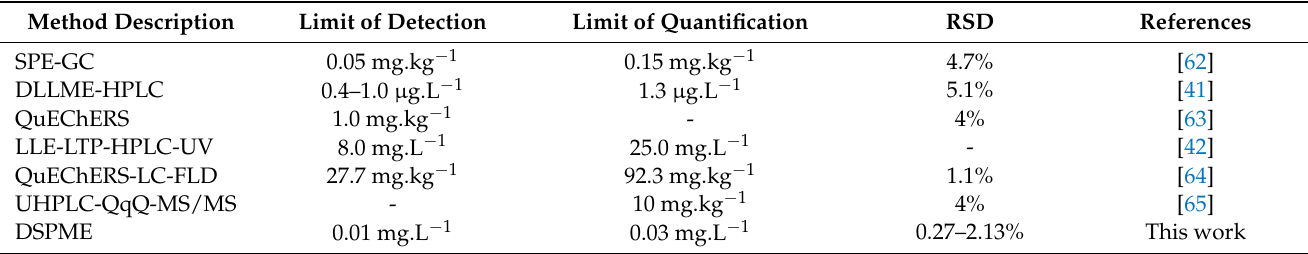
Table 4. Comparison of the carbaryl microextraction method developed in this study with the previously reported methods.